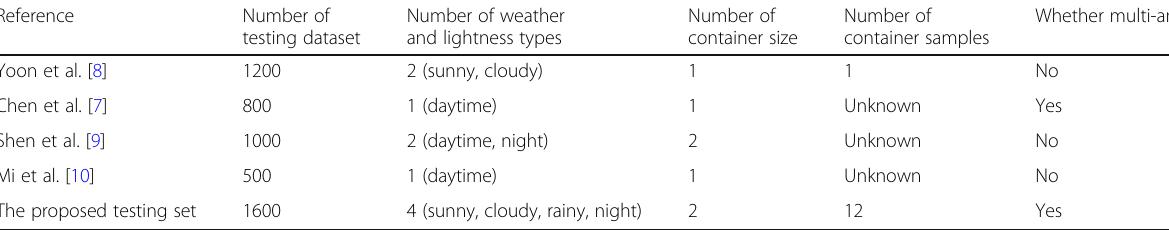
Table 1 Comparison with other datasets